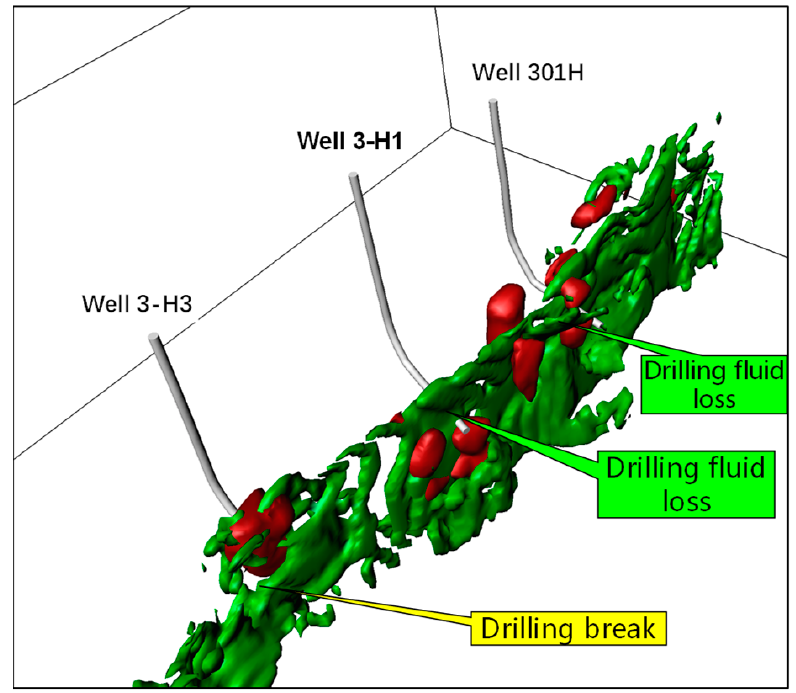
Figure 8. 3D fracture-cave reservoir model showing the well trajectory in well M1 area (the green blocks showing fracture network, the red blocks showing cave reservoirs).